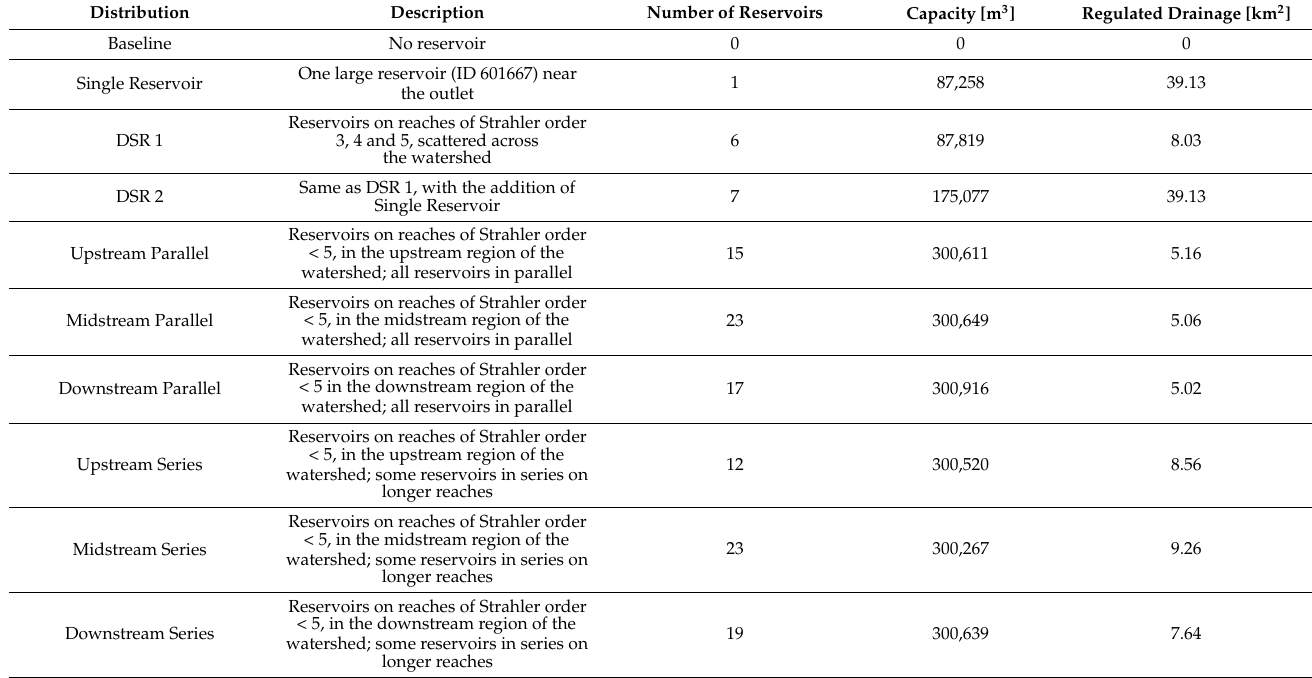
Table 1. Distributions of reservoirs used in the analysis.